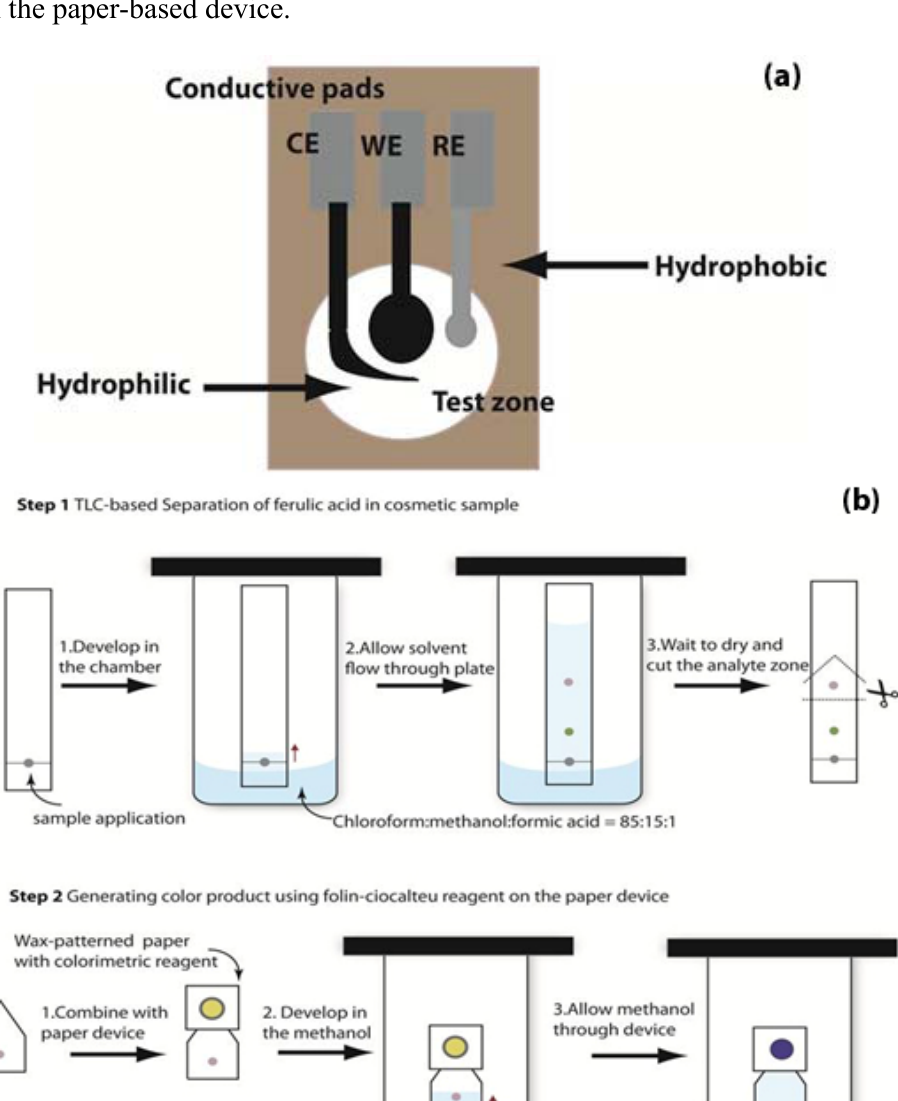
Figure 1. Schematic diagram of the ( a ) paper-based electrochemical device consisting of the electrochemical working electrode (WE), reference electrode (RE) and counter electrode (CE), and the ( b ) separation and quantitative analysis of ferulic acid by coupling TLC with the paper-based